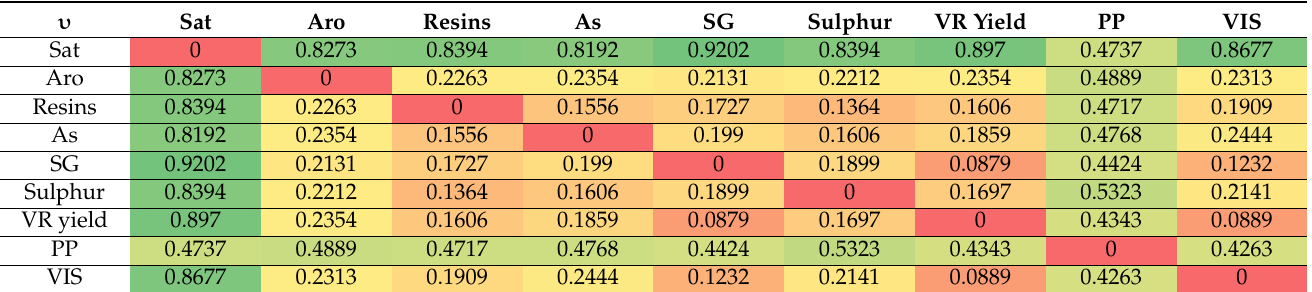
Note: Green color denotes statistically meaningful positive relation; red color denotes statistically meaningful negative relation. The intensity of the color designates the strength of the relation. The higher the color intensity, the higher the strength of the relation. Yellow color denotes